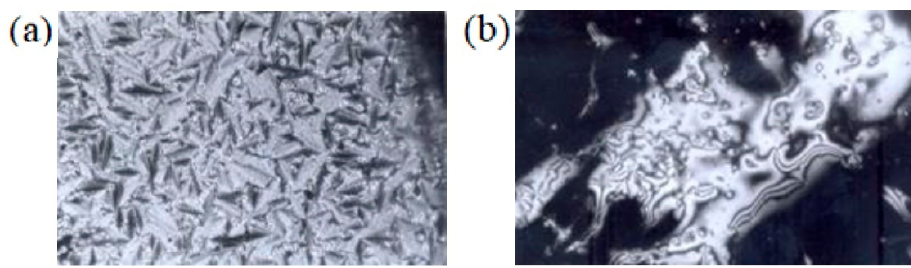
Figure 3. Polarizing optical micrographs (magnification × 320) of SBBDAE in ( a ) smectic A texture obtained from isotropic phase after cooling to 150 °C and ( b ) nematic texture obtained after cooling to 200 ℃ .